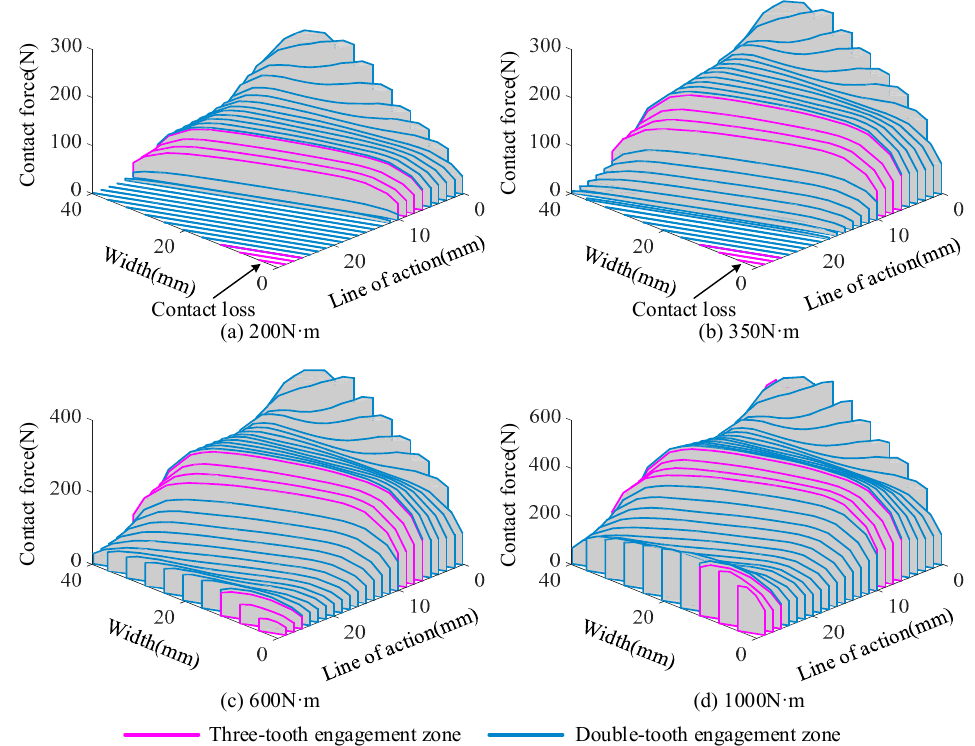
Figure 10. Load distributions in the twelfth mesh cycle considering random cumulative pitch